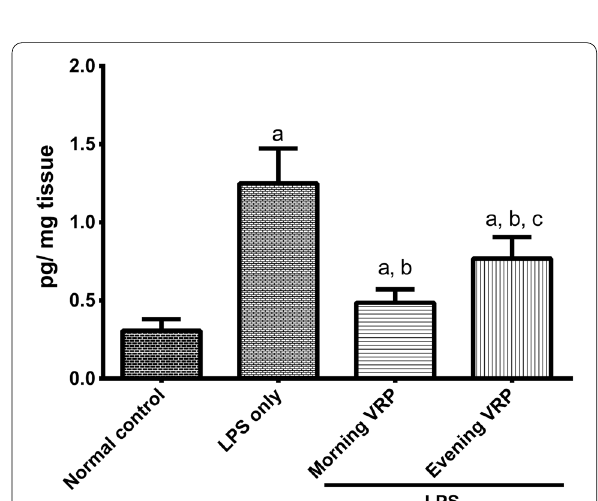
Fig. 9 Effect of VRP on PTAU. Data are expressed as the mean and were analyzed using one-way ANOVA followed by Tukey post hoc test. Values were considered significantly different at P < 0.05. a: significant versus normal control, b: significant versus LPS only, and c: significant versus morning VRP. LPS: lipopolysaccharides, VRP: